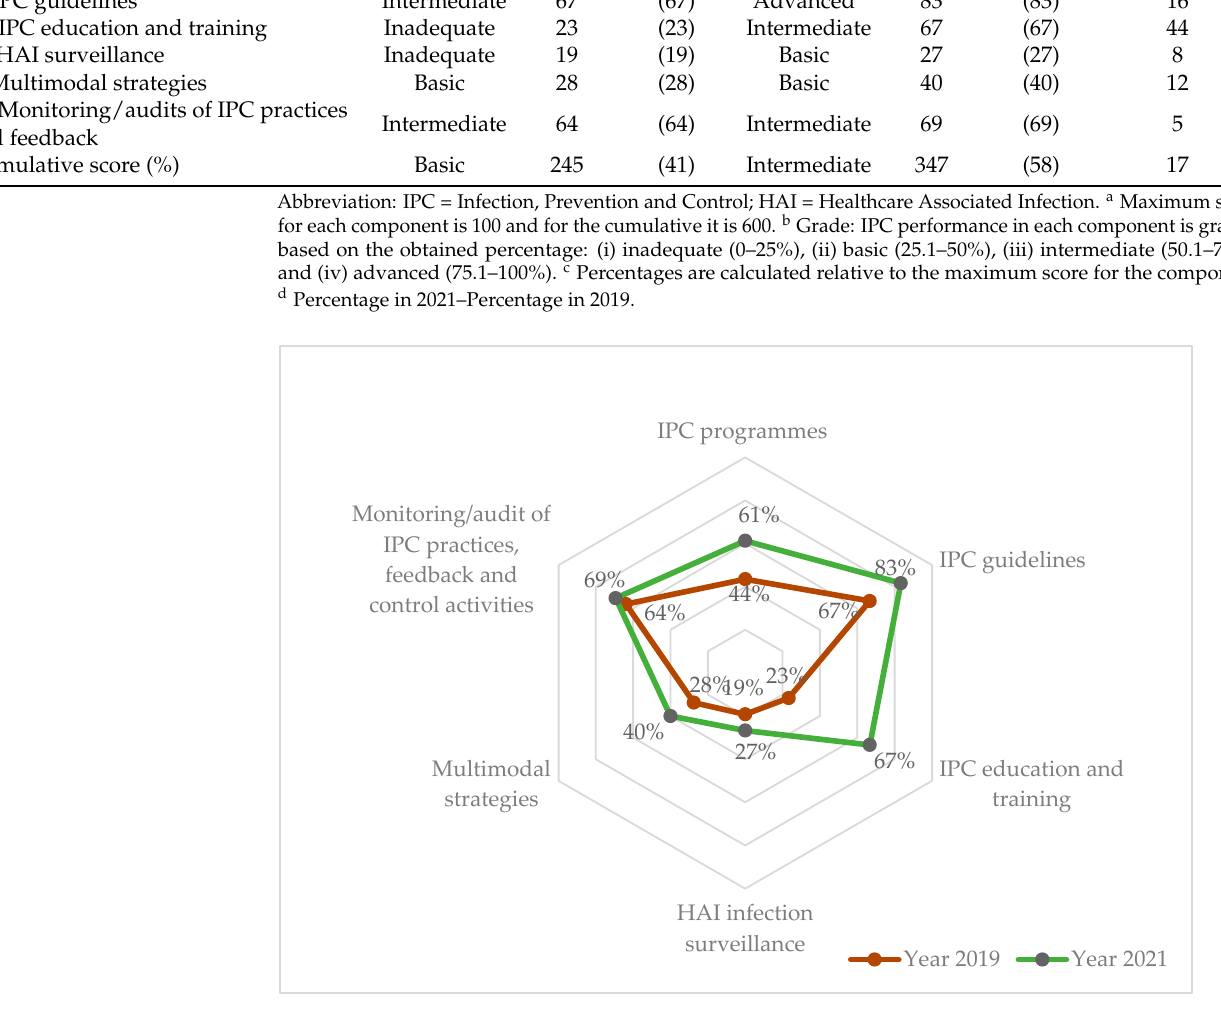
Figure 2. Radar chart showing IPC compliance scores at National IPC unit assessment in 2019 (pre-COVID-19) and 2021 (COVID-19 era) in Sierra Leone. Note: The radar chart shows the IPC component score emanating from the centre (0%) expanding outwards to a maximum of 100%. The 2021 scores (green line) lie outside the 2019 scores (red line), indicating overall improvement in all the components of IPC. Abbreviation: IPC = Infection, Prevention and Control; HAI = Healthcare Associated Infection.